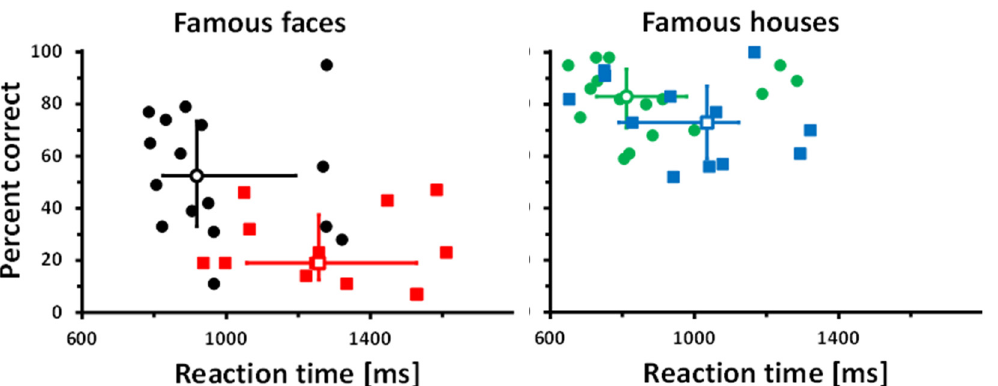
Fig 4. Famous face/house recognition test. Persons with cPA show significantly reduced accuracy and significantly extended reaction times for face recognition (red squares) compared to controls (black circles). For object recognition behaviour is indistinguishable between groups (cPA: blue; controls: green). Group medians are represented by open symbols. Error bars indicate the IQR.